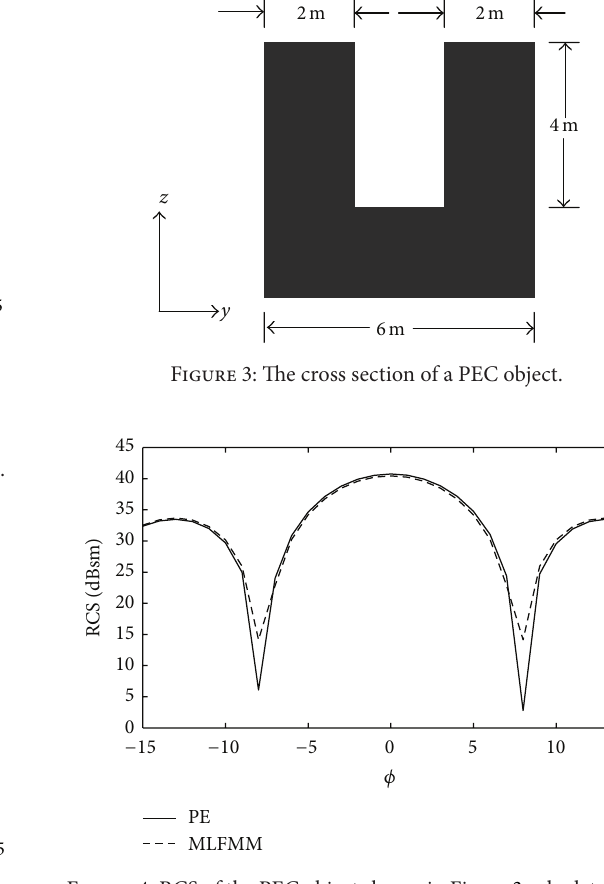
Figure 4: RCS of the PEC object shown in Figure 3 calculated from PE and